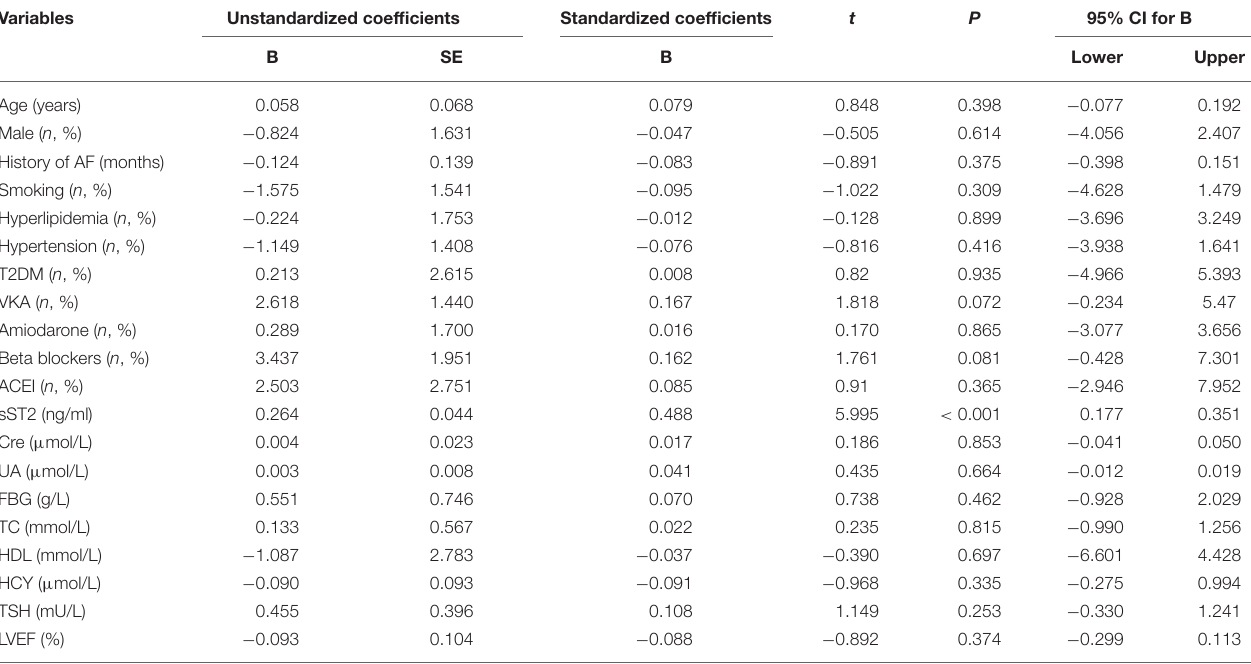
TABLE 3 | Univariate linear regression analyzed the correlations between baseline sST2 and LAVI in persistent AF patients. Variables Unstandardized coefficients